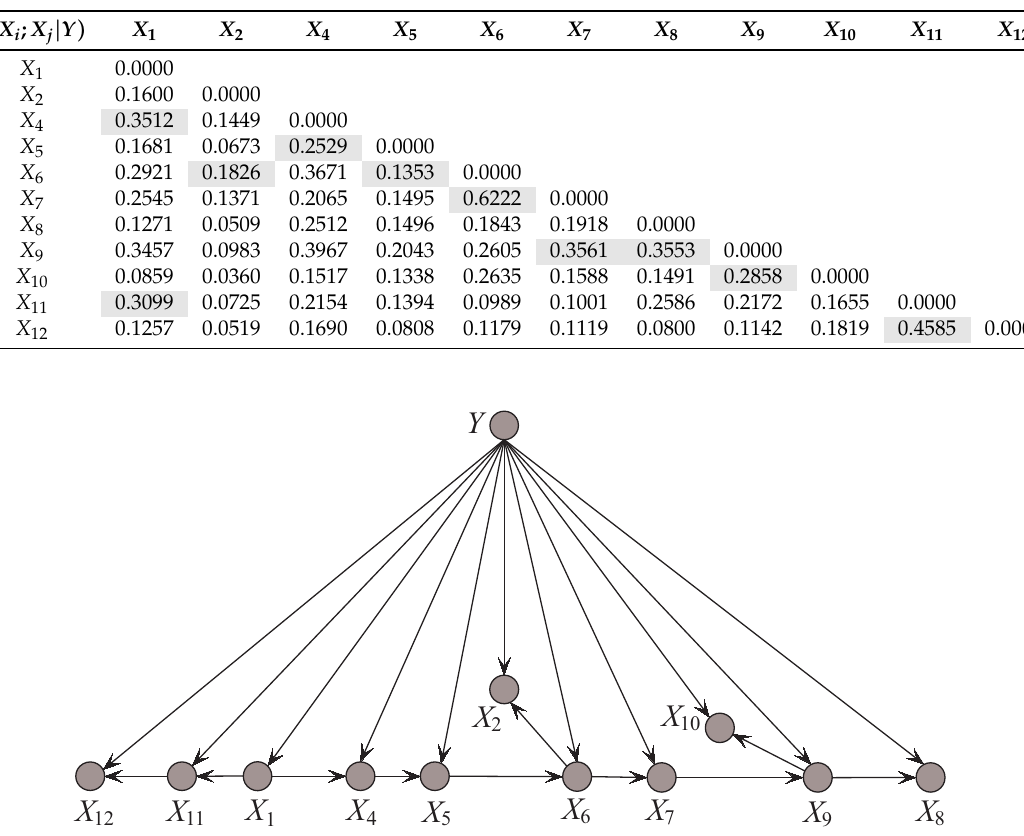
Table 4. The CMI matrix of deciding factors to learning attitude of S-students.